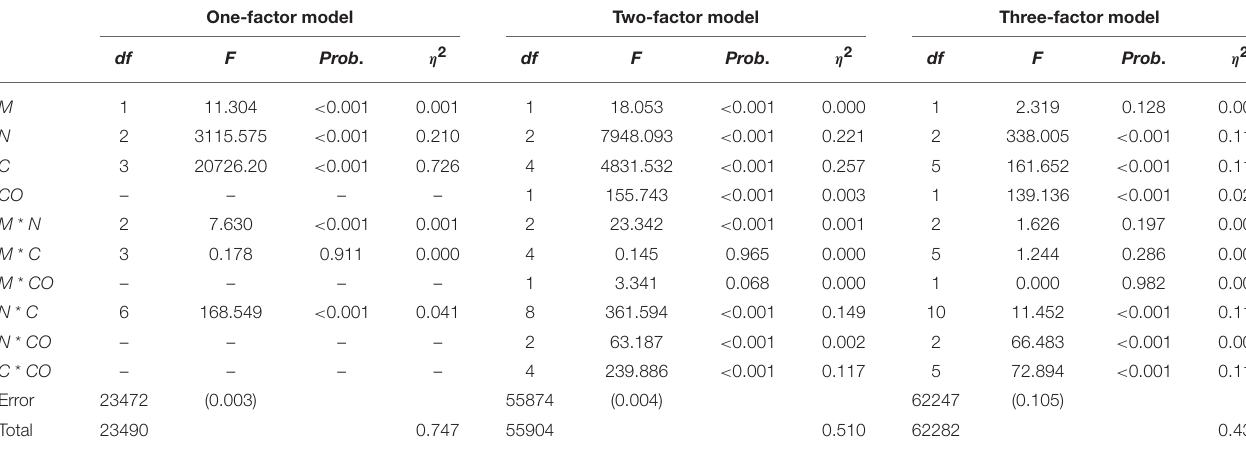
TABLE 3 | ANOVA Results for the RMSD measure in the Monte Carlo study. One-factor model Two-factor model Three-factor model